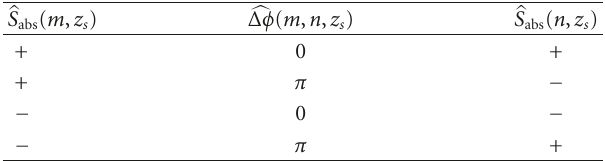
Table 1: Values of Δ φ ( m , n , z ) . Table 2: Absolute mode sign choice rule: the absolute sign of mode n (cid:23) S abs ( n , z s ) depends on the absolute sign of mode m (cid:23) S abs ( m , z s ) and the pass function (cid:24) Δ φ ( m , n , z s ) (where n > m